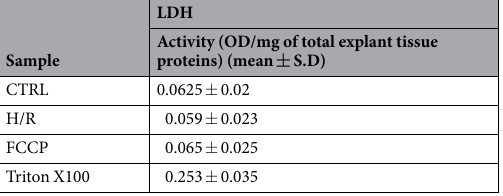
Table 1. Placental explant cultures